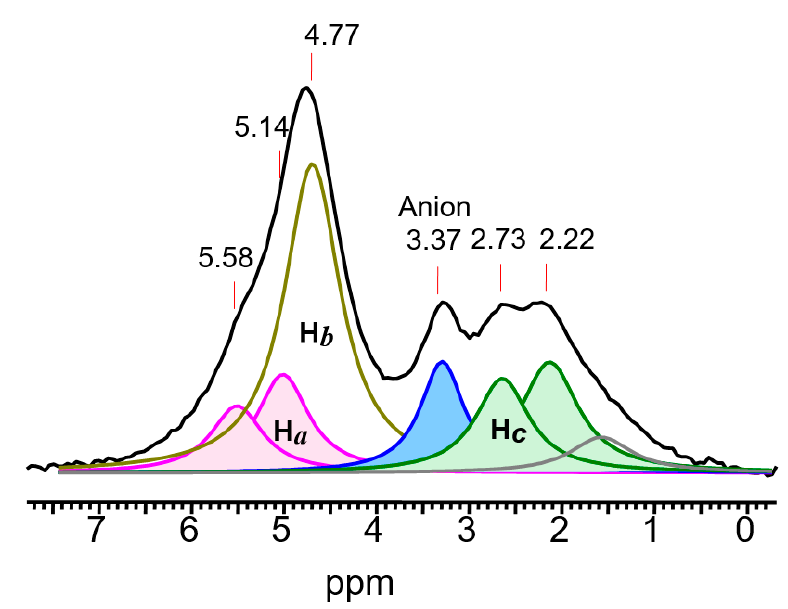
Figure 3. 1 H MAS NMR spectrum of the (C 2 H 3 ) 2 Cl + {Cl 11 − } salt.